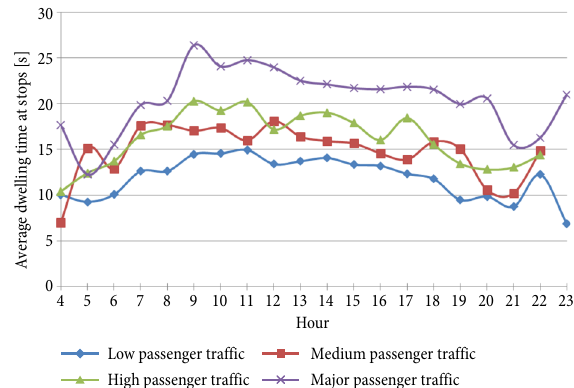
Fig. 2. Mean values of dwell time at stops according to time intervals and volume of passenger-traffic at stops ( source: research by the authors)